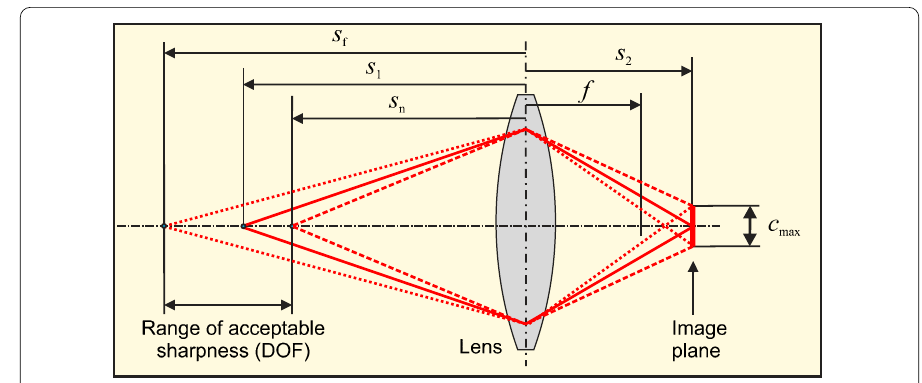
Figure 7 Illustration of the depth of field: All point sources, which lie within the distance range of acceptable sharpness, have an image diameter that is smaller or equal to the circle of